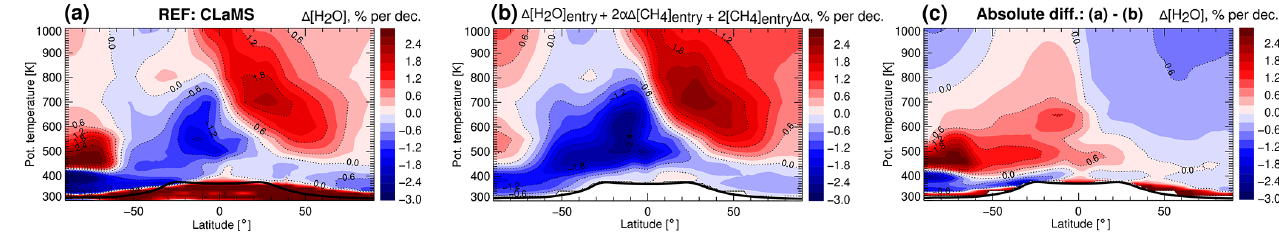
Figure 3. Contributions to H 2 O trends during 1990–2017. H 2 O trends during the 1990–2017 period and their reconstruction, shown in percentage per decade with respect to the 1990–2017 climatology. Panel (a) represents the reference (REF) true stratospheric H 2 O trend cal- culated from the CLaMS simulation driven by ERA-Interim reanalysis, (b) shows the reconstruction as the sum of the different contributions from Fig. 2, and (c) shows the absolute difference between (a) and (b) . The black line is the tropopause calculated from ERA-Interim. Note that due to the simple parameterization of ice microphysics and the omission of a parameterization of convective processes in CLaMS, the simulated H 2 O shown in (a) is meaningful only above the